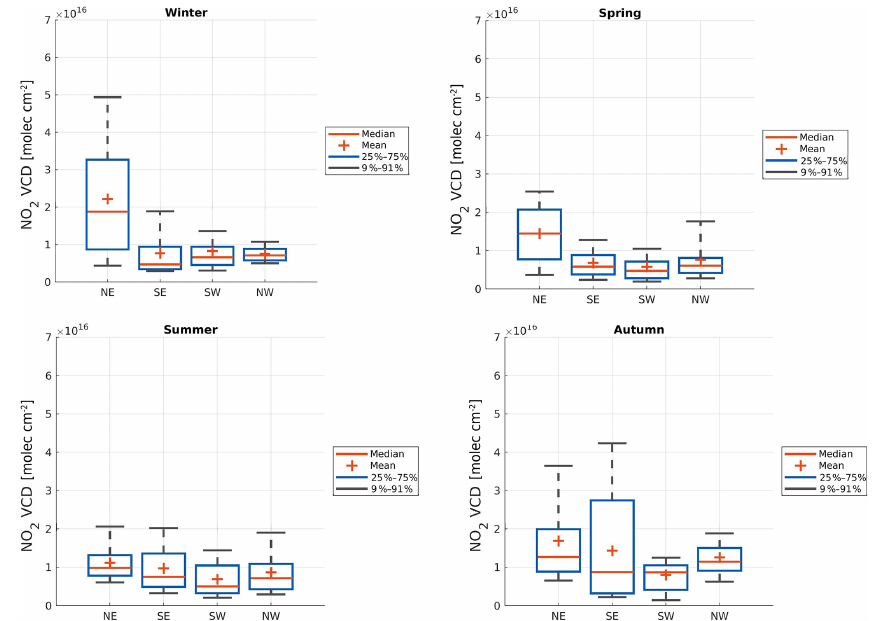
Figure 10. Box-and-whisker plots representing, for each season, the tropospheric NO 2 column as a function of the wind direction. The MAX- DOAS columns are derived by the parameterization technique in the visible wavelength range (all the azimuthal directions are included) and the wind observations from the meteorological station on the BIRA-IASB